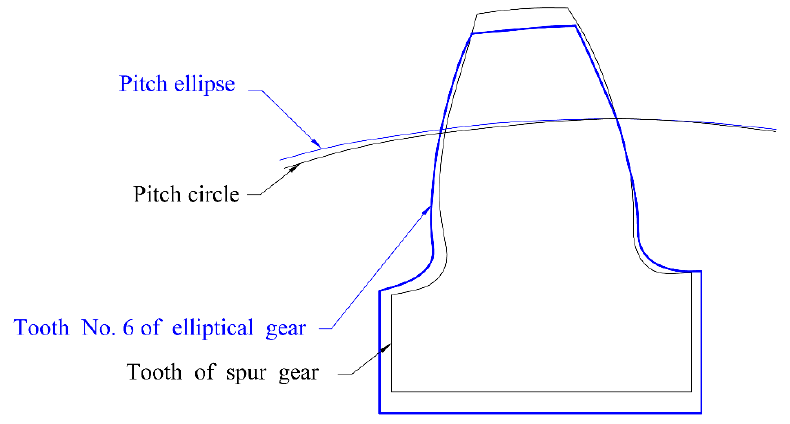
Figure 15. Tooth profile comparison for tooth No. 6. Standard spur teeth are teeth with a symmetrical profile. Left and right active—involute curve has the same shape. The teeth of the designed non-circular gear have an asymmetrical tooth profile. The left involute curve of the tooth profile is different from the right. In Figure 16 is an example of the difference for the left and right side of tooth number 6 of the proposed gear. It is the result of different evolutes of involute tooth curves (Figure 10).